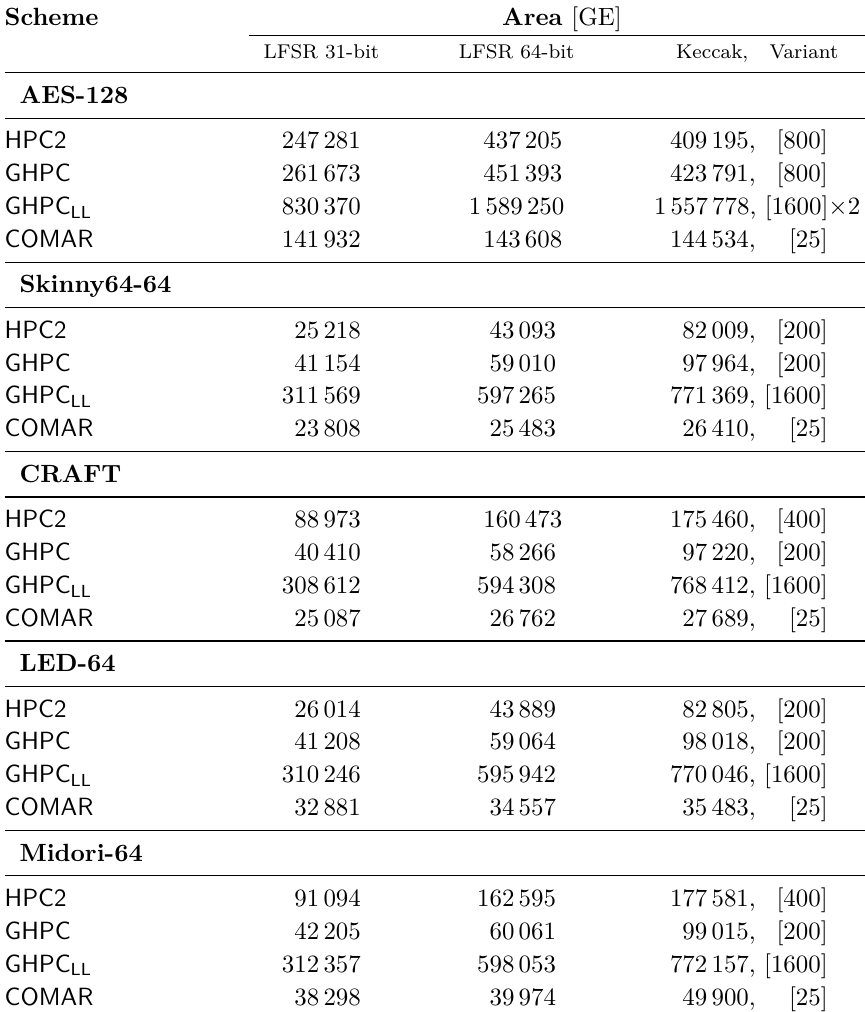
Table 3: Area footprint of first-order round-based full cipher encryption functions, including